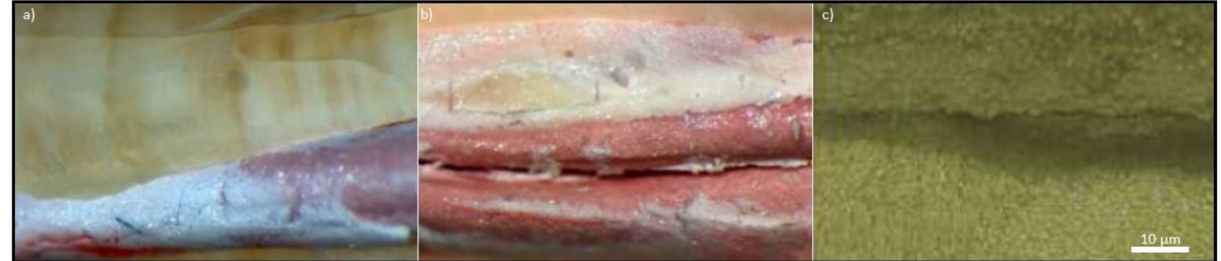
Figure 15. Thick interlayer of the densifier after cold filling the root canal with resilon (( a , b )—LSM, ( c )—LCM): ( a ) covering the main stud in the apical section; ( b ) overlapping additional studs and a leakage on the border of the main stud and the complementary material due to delamination of the sealing material in the central part of the root canal; ( c ) a close bond between the filling and the root